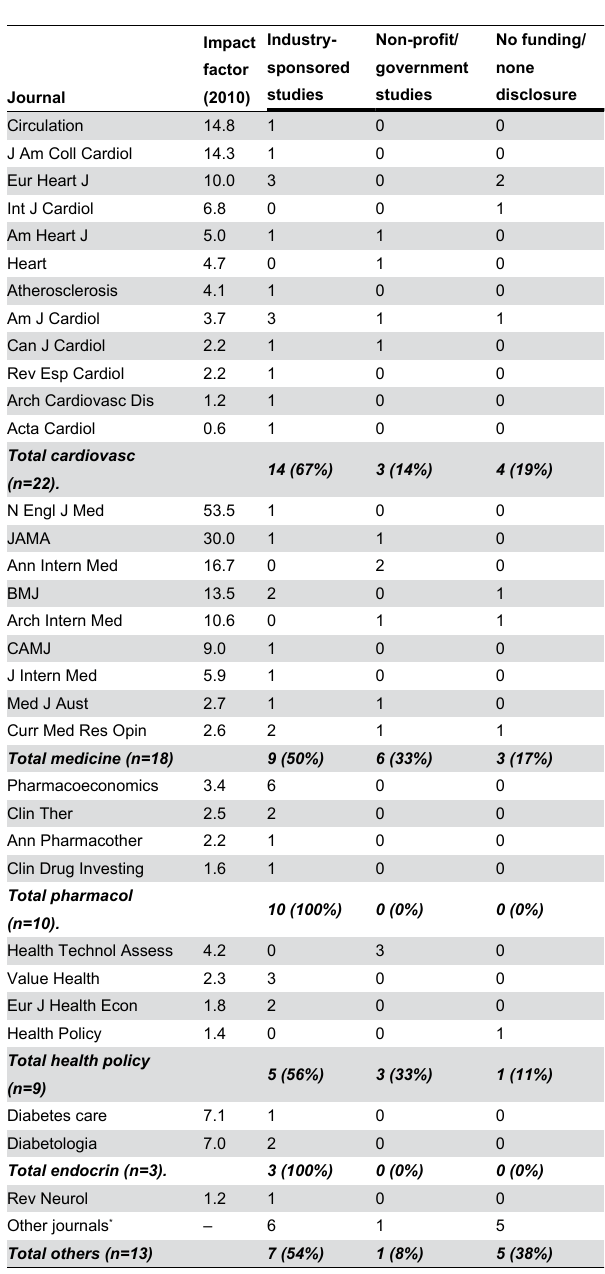
Table 2. Journals and impact factor scores by funding source